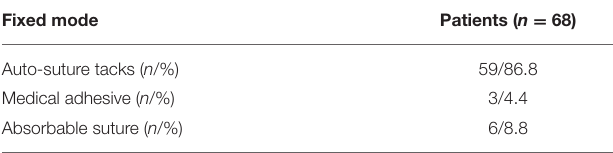
TABLE 3 | Fixation of mesh in patients who underwent laparoscopic hernia